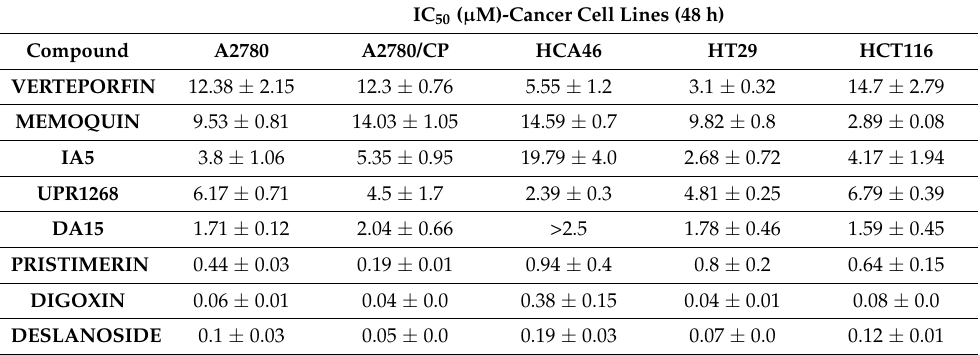
Table 2. Cytotoxic effect of the seven selected compounds against several cancer cell lines using an MTT